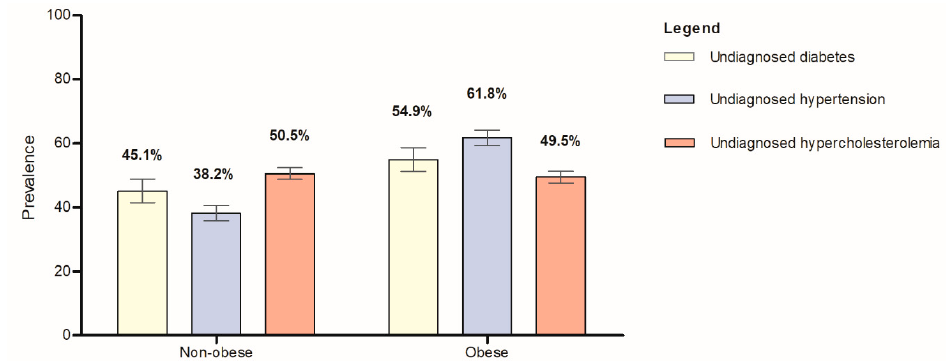
Figure 2. The prevalence of undiagnosed diabetes mellitus, undiagnosed high blood pressure, and undiagnosed hypercholesterolemia stratified by central obesity status among the Malaysian adults ( n = 12,978).